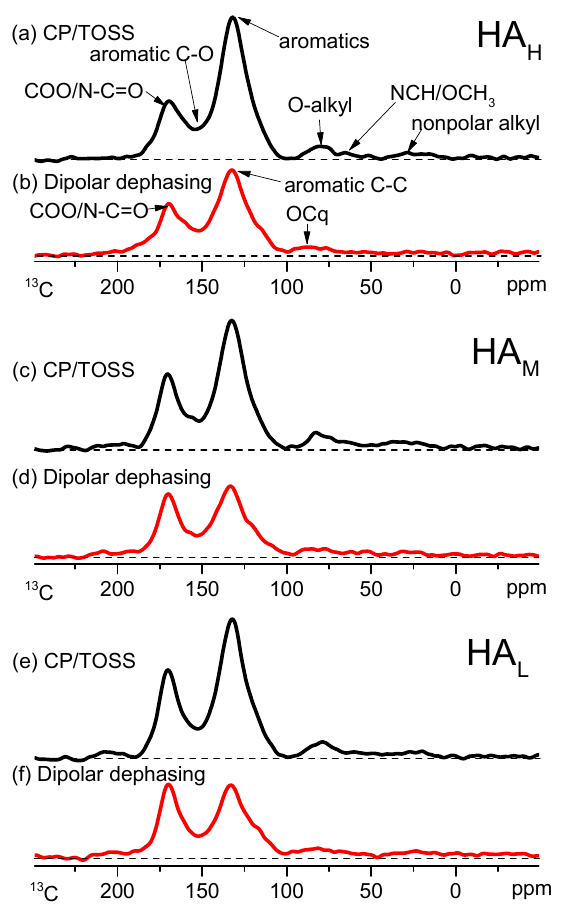
Figure 2. 13 C nuclear magnetic resonance (NMR) spectra of HA fractions derived from weathered coal by unselective cross polarization with cross polarization/total sideband suppression (CP/TOSS) ( a , c , e ) and dipolar dephased techniques ( b , d , f ).